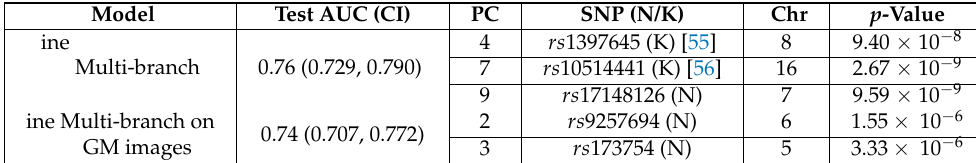
Table 2. Multi-branch models with test AUCs (95% confidence intervals (CIs)) as well as contributing principal components and significant SNPs with their chromosomal positions and p -values. Novel and known SNPs are indicated by N and K,